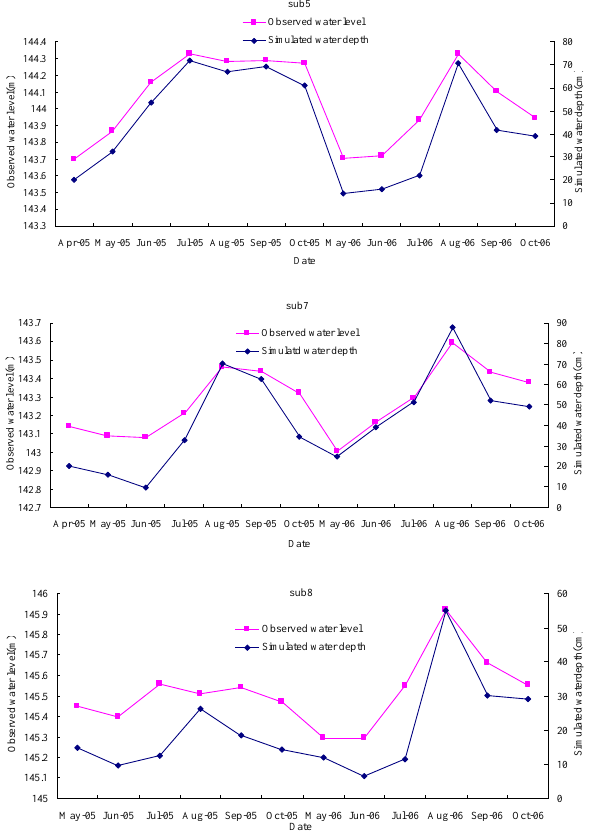
Fig. 9. Comparison between observed water level and simulated water depth in subbasins of the central zone in the Zhalong Wetland, Northeast China, for 2005 and 2006.